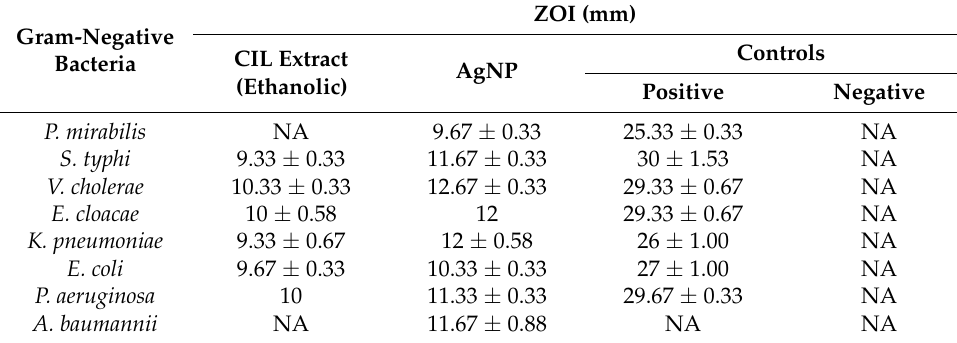
Table 3. Antibacterial activity of CIL ethanolic extract and synthesized AgNPs against Gram-negative bacteria.